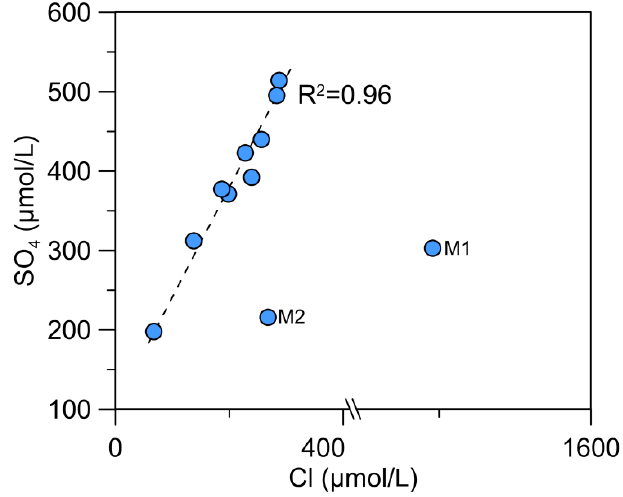
Figure 2. The relationship between Cl − and SO 42 − in mainstream waters.